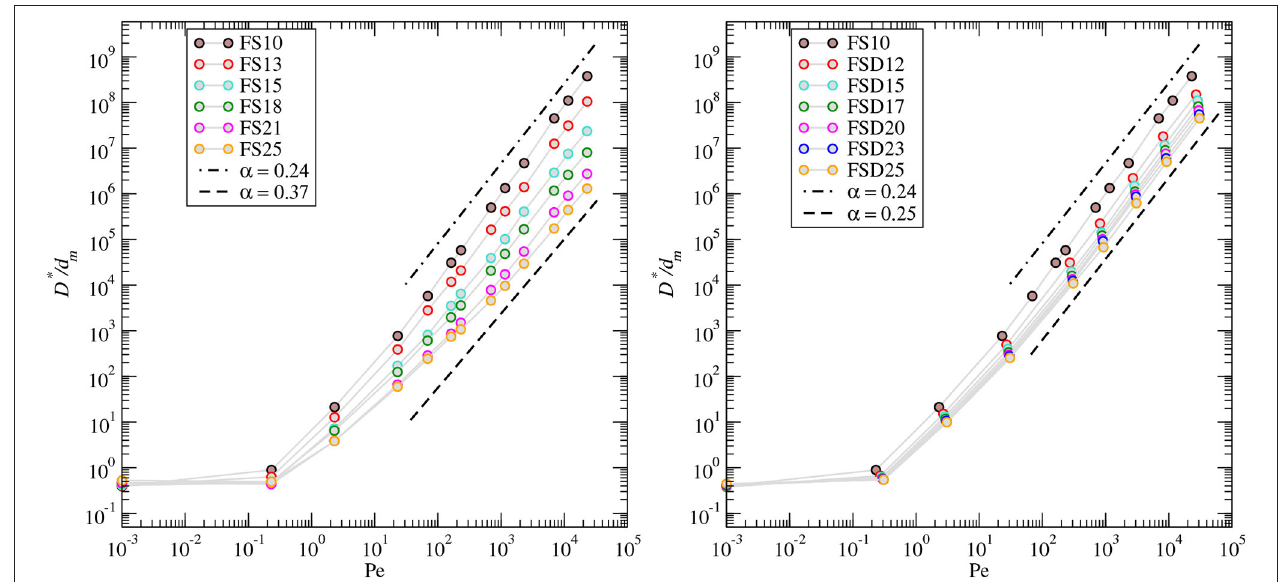
FIGURE 11 | Asymptotic dispersion coefficient vs. Pe for the FS and FSD